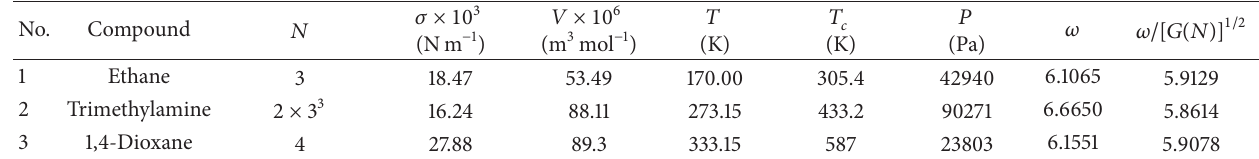
Table 3: To the definition of the dependence of 𝜔 on 𝑁